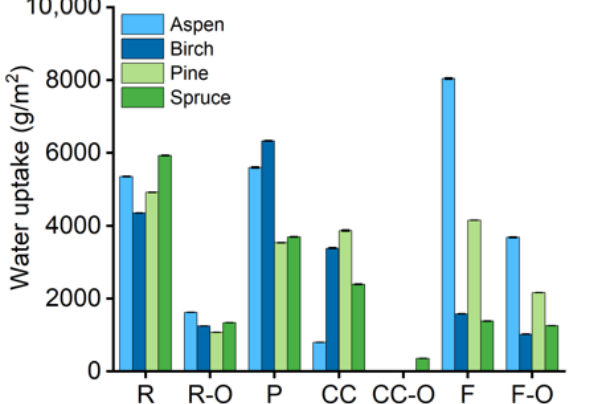
Figure 4. Water uptake (g/m 2 ) of aspen, birch, pine and spruce in liquid water floating at 96 h. Error bars for SD.